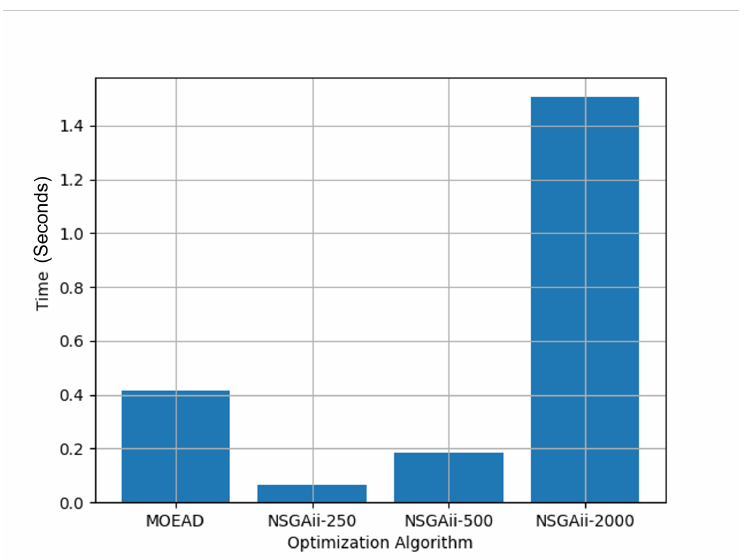
Figure 11. Time comparison for MOEA/D and variations of NSGA2 for finding the Pareto-front.